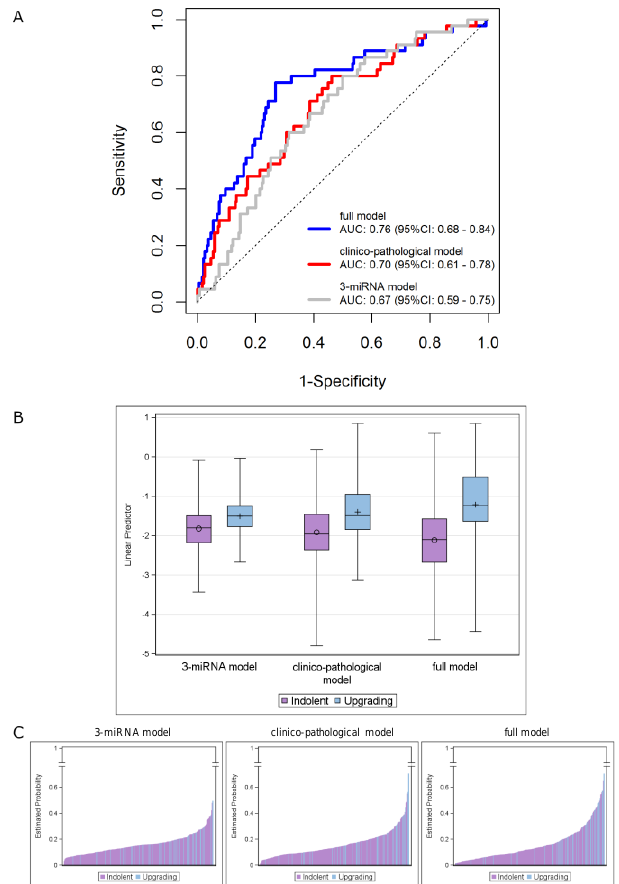
Figure 3. Integrating the 3-miRNA model into the clinicopathological model (including age, PSA density and maximum percentage of tumor). ( A ) ROC curves in the overall series of AS patients. ROC curves from 3-miRNA (gray line), clinicopathological (red line) and full (blue line) models. ( B ) Distribution of the linear predictors estimated for the 3 fitted models according to the upgrading (light blue) and indolent (purple) status, in the overall series. Each box indicates the 25th and 75th percentiles. The horizontal line inside the box indicates the median, and whiskers indicate the extreme measured values. ( C ) Bar plots showing the estimated probabilities for each patient according to the upgrading (light blue) and indolent (purple) status for the 3 fitted models (from left to right: 3-miRNA, clinicopathological and full model). The full-model score was calculated for individual patients as follows: (0.048 × age at biopsy) + (0.022 × Max PCa length) + (1.402 × PSA density) + (1.013 × miRNAscore) + ( −